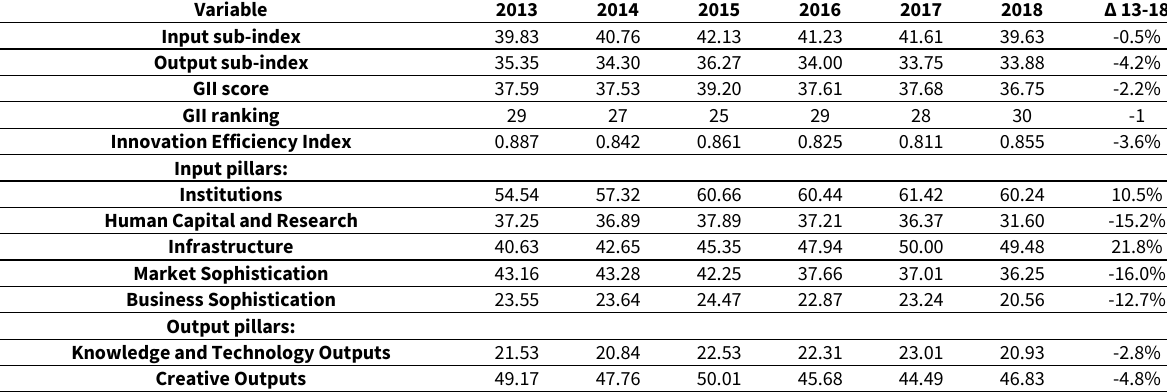
Source: Own calculations. Table 4. Eurozone countries GII scores